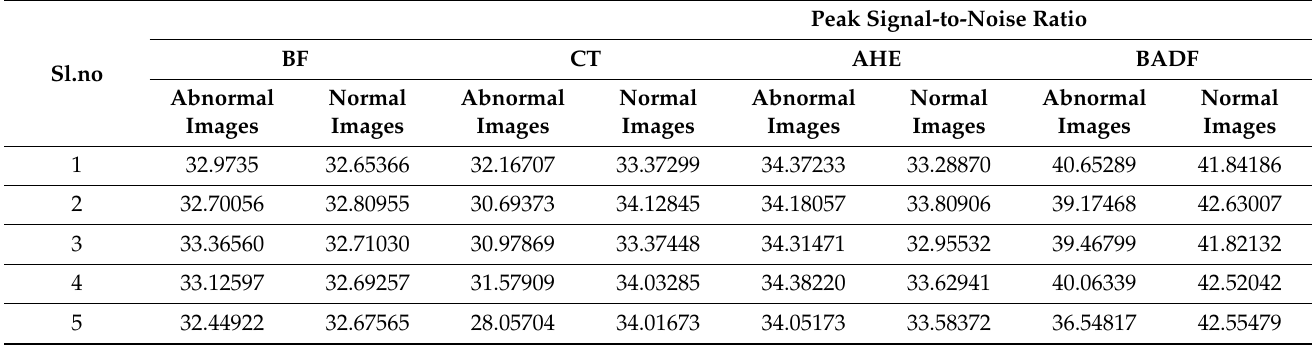
Table 3. Parameters for measuring preprocessed images. The peak signal-to-noise ratios for various filters in five abnormal and normal images are